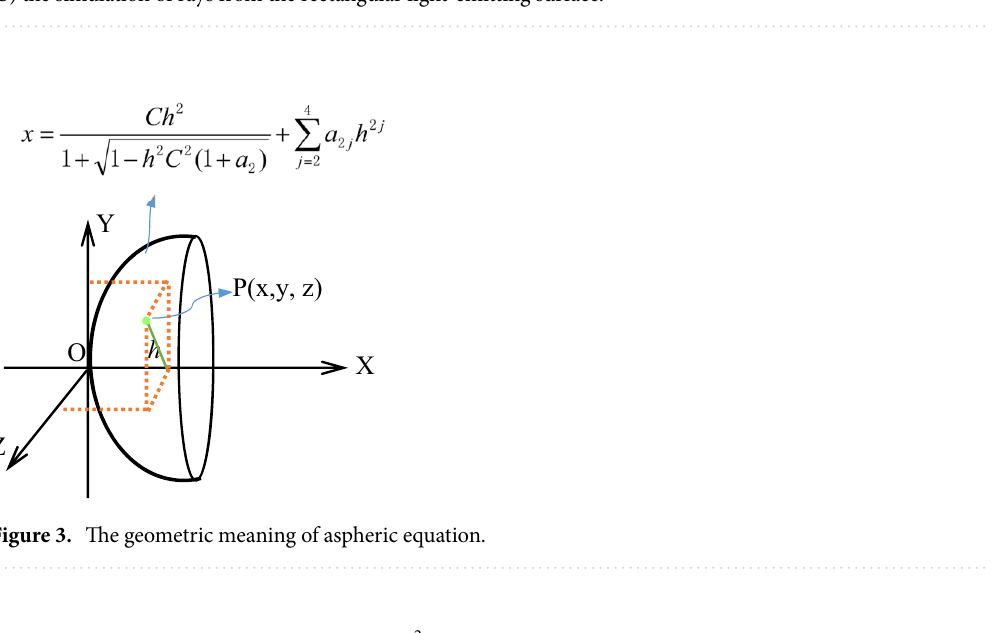
Figure 2. The schematic diagram of emergent light from laser diode. ( a ) The emergent beam structure diagram, ( b ) the simulation of rays from the rectangular light-emitting surface.